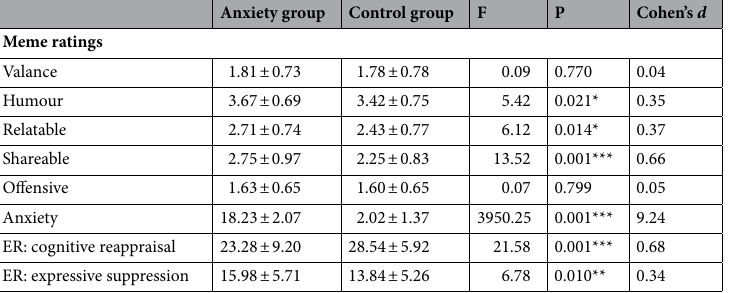
Table 1. Ratings of memes for the control and severe anxiety symptoms groups whilst observing COVID-19 memes (means ± standard deviation). *Sig at < 0.05, ** < 0.01, *** < 0.001.